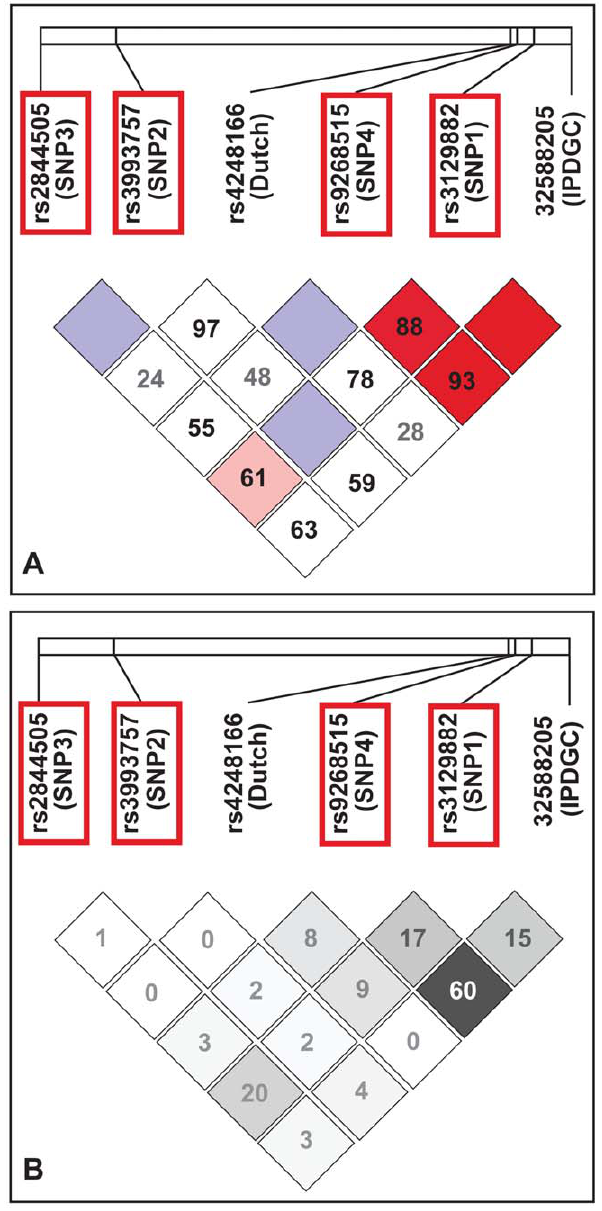
Figure 2. LD among the four significant SNPs from NGRC conditional analysis and the most significant HLA SNPs from other PD GWAS’s. LD was measured as D 9 (panel A) and as r 2 (panel B). NGRC SNPs are numbered 1–4 and marked in red frame. The most significant HLA SNP from other GWAS’s are indicated by rs number and the study name. Numbers in cells are % D 9 (panel A) and % r 2 (panel B). Red cell without a number reflects D 9 =1, blue cells without a number reflect D 9